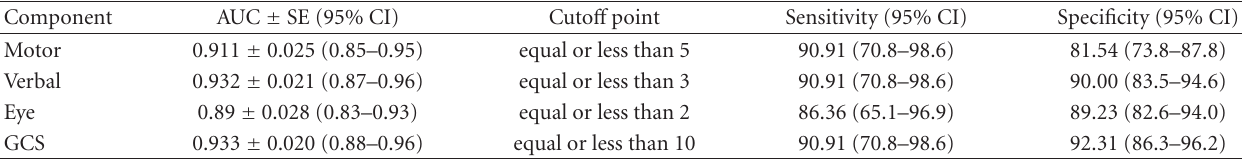
Table 4: Areas under the ROC curves of each component as well as total